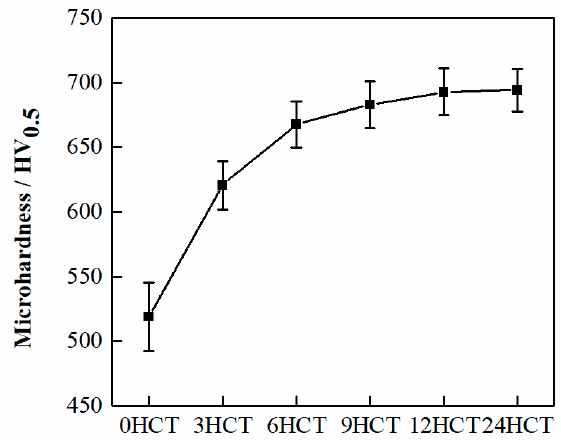
Figure 5. Average microhardness and standard deviation of microhardness.